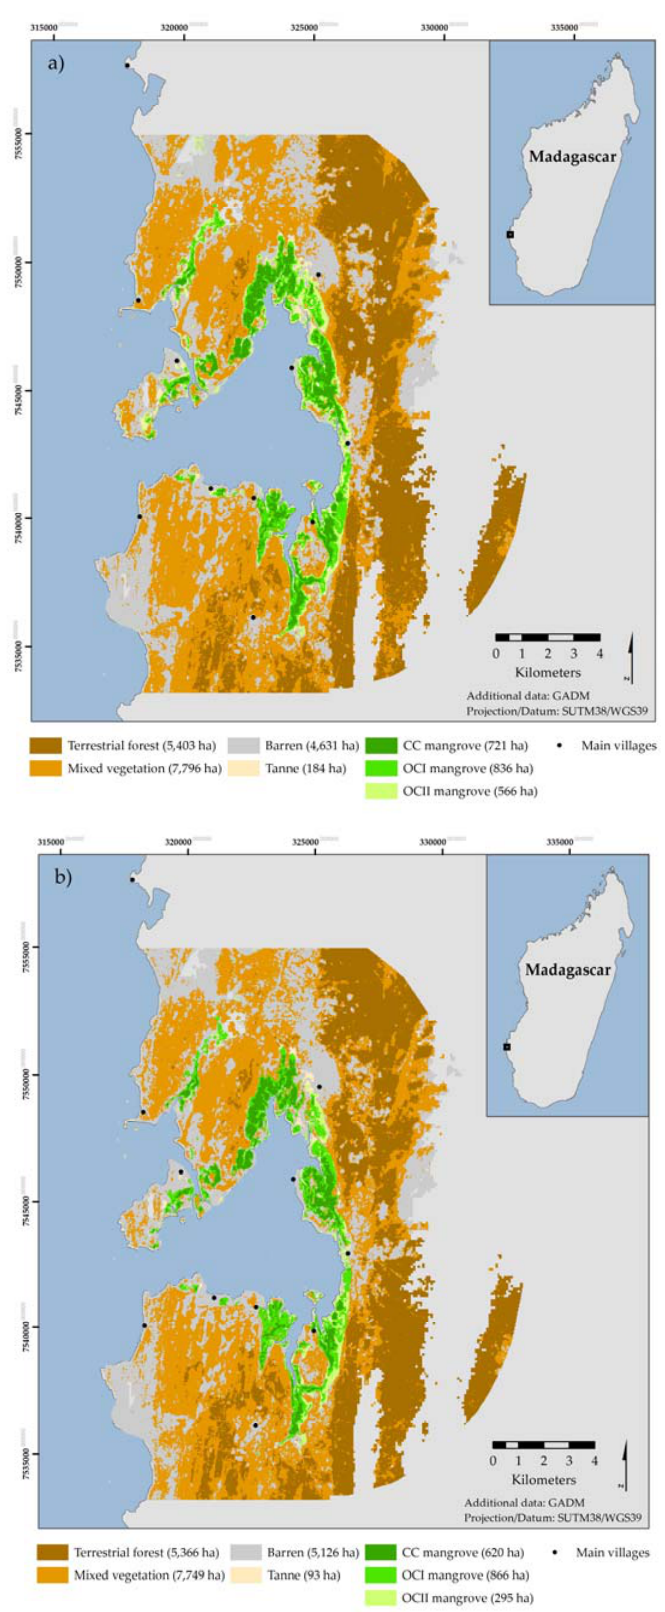
Figure 7. The 2002 Landsat classification results ( a ). The 2014 Landsat classification results. Individual class areas are shown in brackets ( b ).